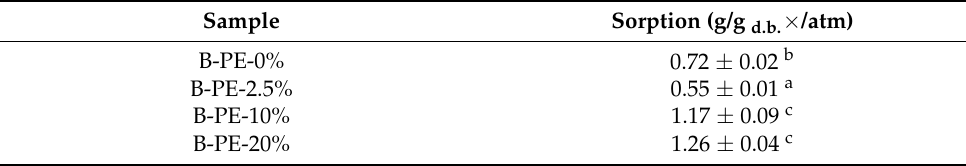
Table 4. Sorption coefficients were obtained from the polynomial